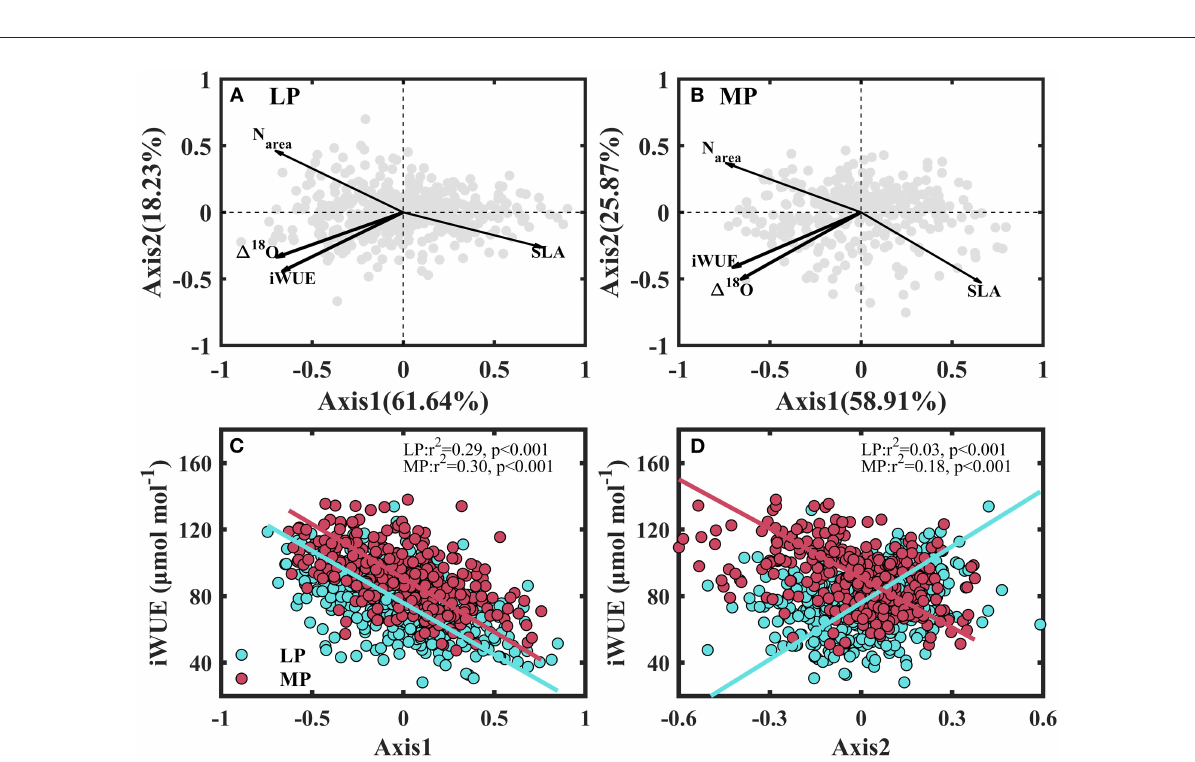
FIGURE7 Principal component analysis (PCA) of intrinsic water use efficiency (iWUE) and leaf functional traits (A,B) and relationship between the principal component axes of PCA of leaf functional traits and iWUE (C,D) . SLA, specific leaf area; N area , leaf nitrogen per unit area, and 1 18 O, the 18 O enrichment in leaf water above source water. LP, Loess Pleateau; MP, Inner Mongolia